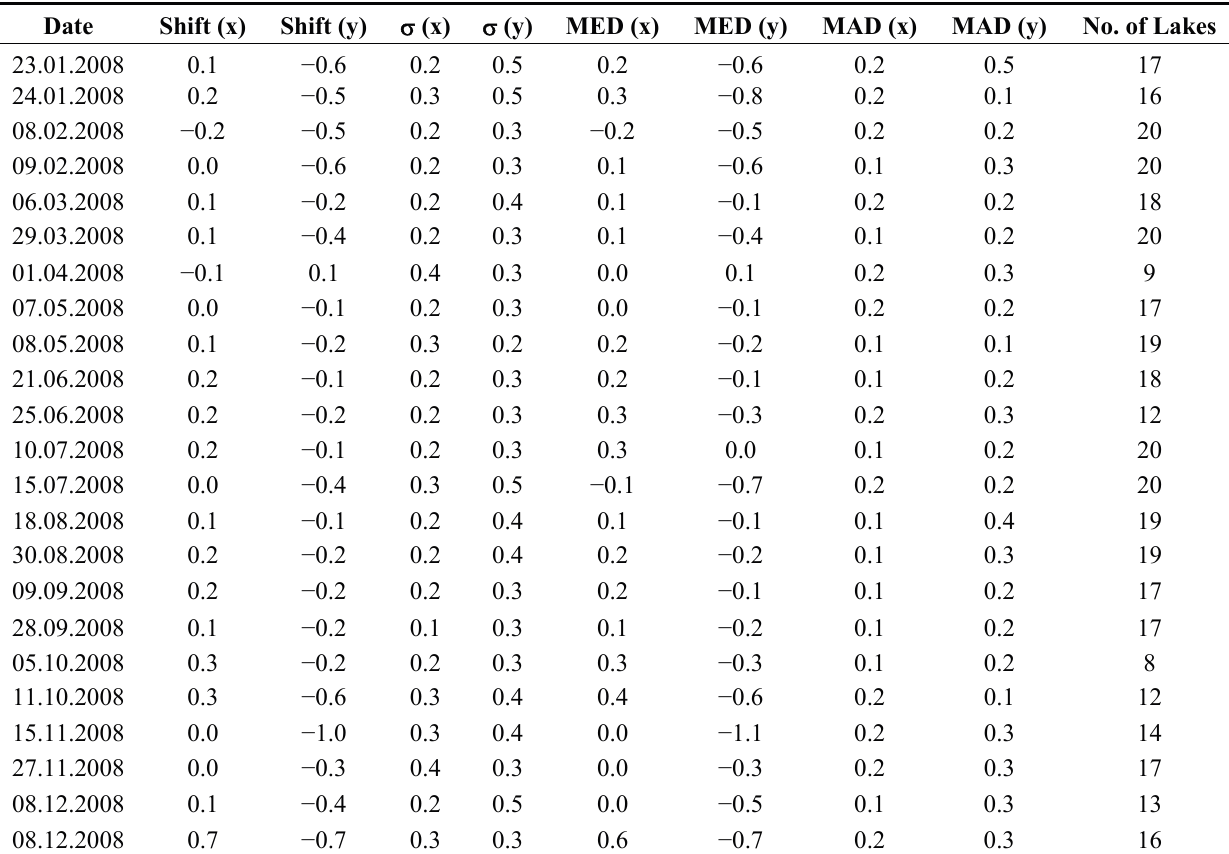
Table 5. Absolute accuracy evaluation; statistical summary from the lake shifts in AVHRR images acquired from NOAA-18. All values are in pixels except the number of lakes and are derived from signed